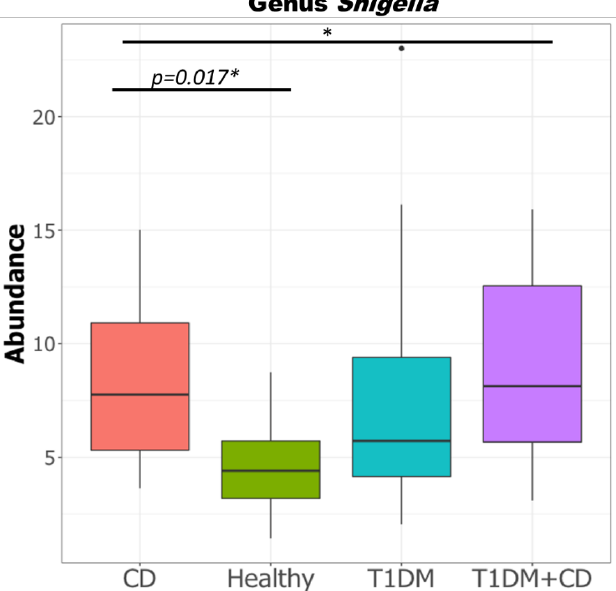
Figure 5. Difference in relative abundance of genus Shigella in the four study groups CD, T1DM, healthy control, T1DM+CD. (Kruskal-Wallis test with false discovery rate (FDR)-Bonferroni corrected p values. * p ≤ 0.05). Significant difference was observed across the four groups as well as between CD and healthy controls. Abbreviations: T1DM = Type 1 Diabetes; CD = Coeliac disease.